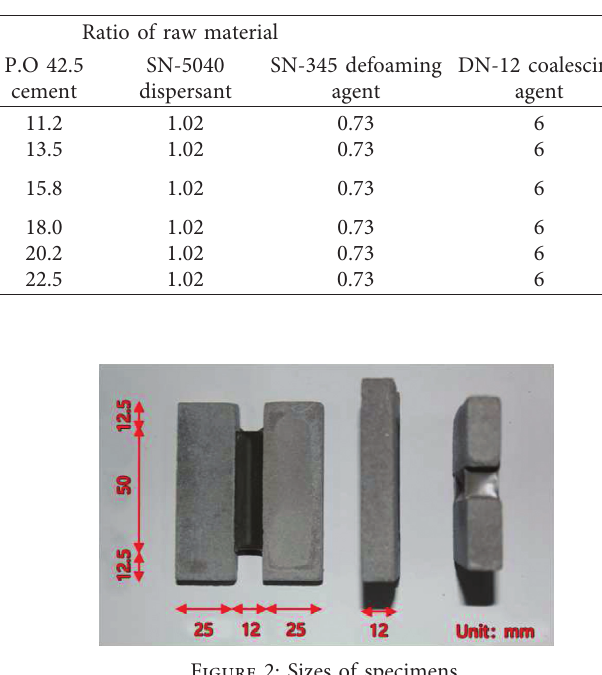
Table 3: Ratios with cement ratio as the variable.